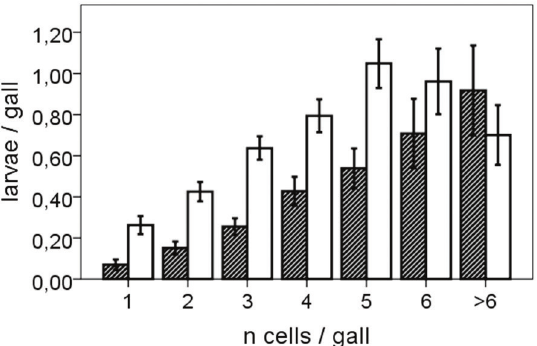
Figure 2. Average frequency of E. serratulae (black) and E. robusta (white) larvae as function of cell numbers per gall. Analysed material: 260 gall samples with a total of 7,064 galls collected from 1976 to 1993 in eastern France, southern Germany and eastern Austria.